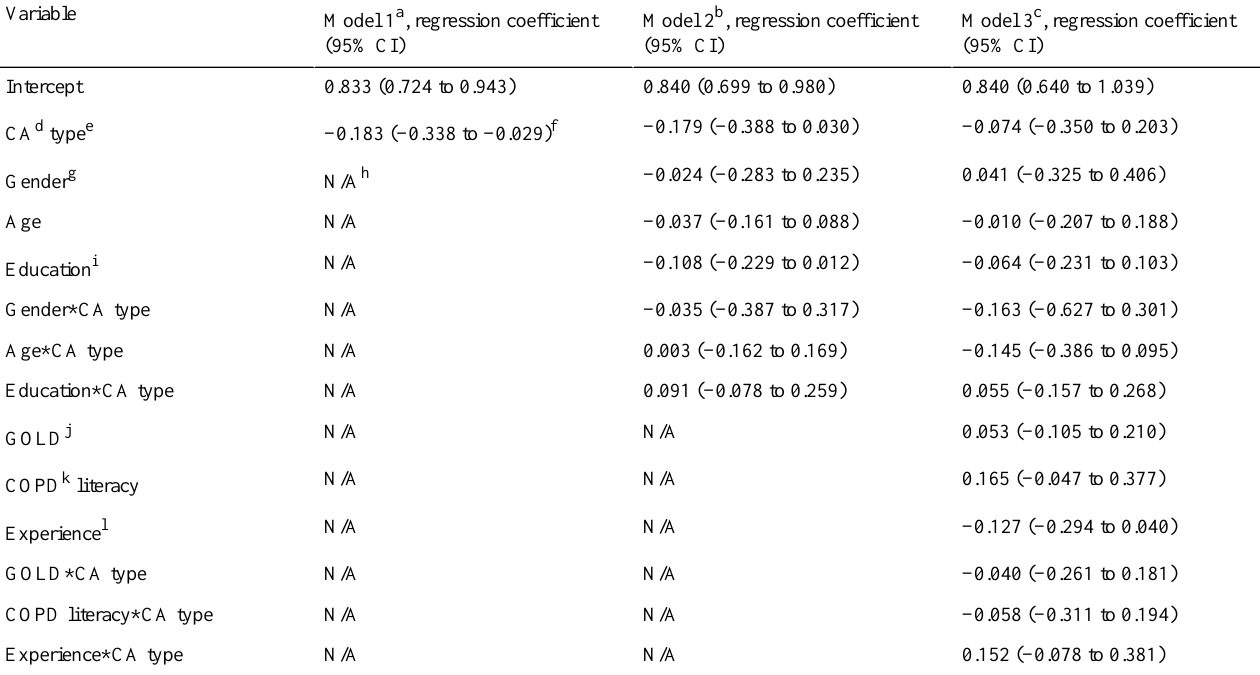
Table 7. Regression of conversational agent type, participants’ demographics, and chronic obstructive pulmonary disease–related characteristics in terms of participants’willingness to change their behavior after conversational agent